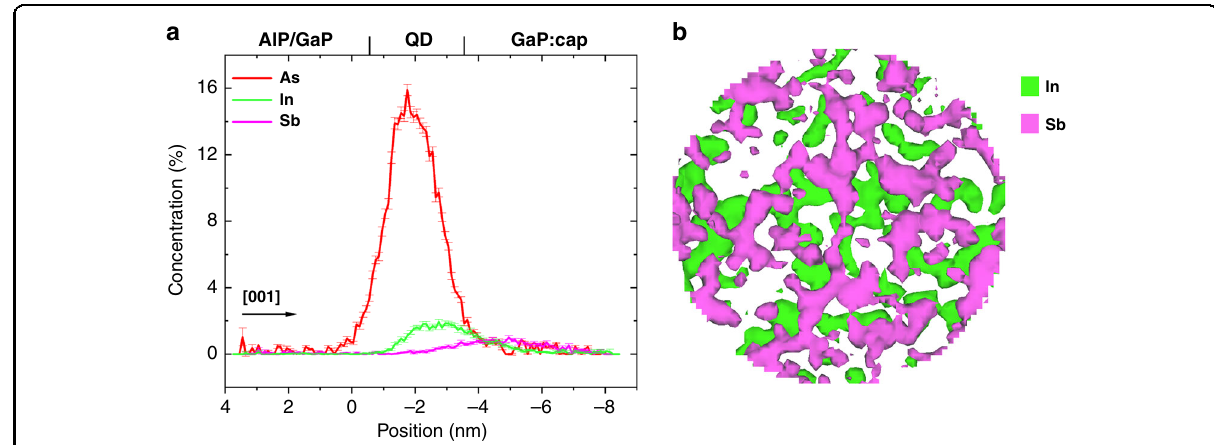
Fig. 5 APT evaluation of the QD constituent elements. a APT concentration pro fi le showing only As, In, and Sb is generated from the 30nm diameter slice shown in panel b rather than from the full dataset that is shown in Fig. 4. The arrow indicates the growth direction [001]; b 30 nm diameter slice of iso- concentration surfaces created with In = 2.0 at.% and Sb = 1.0 at.%, showing the anticorrelation in the spatial distribution of the In- and Sb-rich